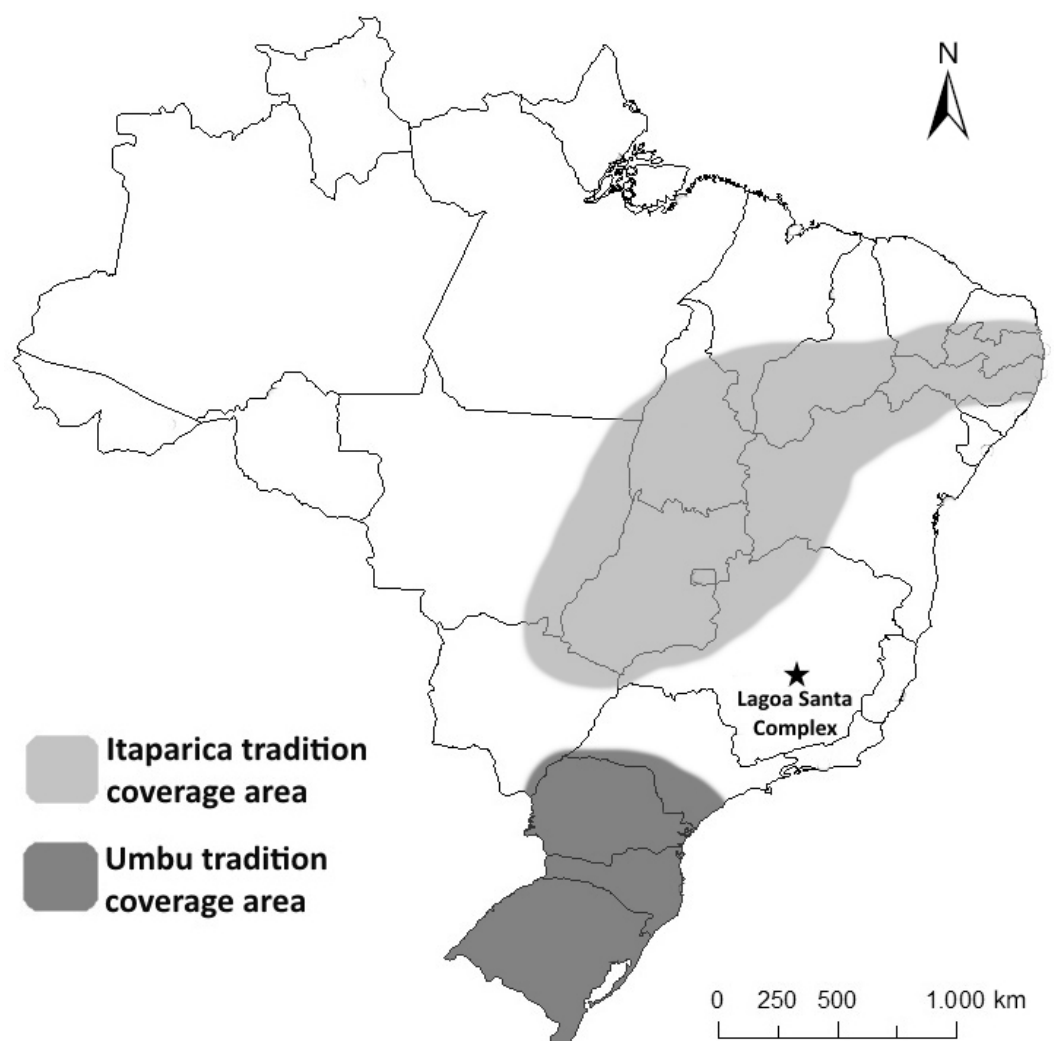
Figure 1. Lagoa Santa archaeological sites complex location and assumed coverage areas of Itaparica and Umbu